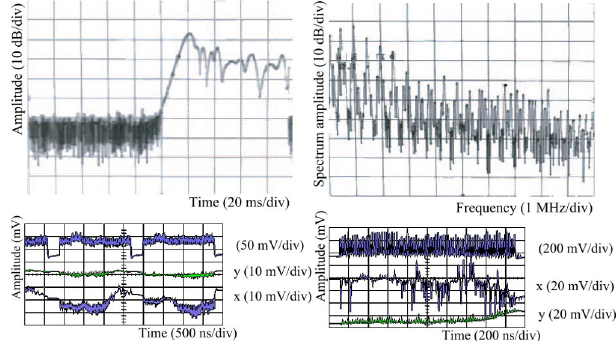
FIG. 26. (Color) Instability footprint for a bunch population of 5 : 5 (cid:1) 10 10 in the CERN PS [36]; the signal obtained from a spectrum analyzer with zero span (upper left picture), Fourier analysis from 0 to 10 MHz (upper right), signal from a pickup in the PS ring several tens of ms before extraction (bottom left) and from a pickup in the PS-to-SPS transfer line (bottom